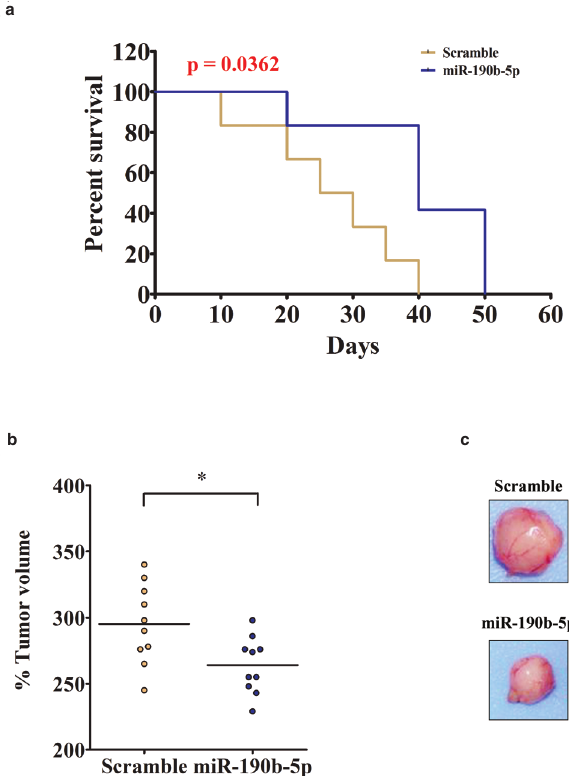
Fig. 6. MiR-190b-5p inhibits pancreatic cancer in mouse model. (a) Survival study of KPC mice administrated with 1 mg/kg of miR-190b-5p or scramble control formulated in nanoparticle-based vectors. KPC mice were enrolled onto studies when the tumor size was reaching 200 ± 50 mm 3 as measured by 3D ultrasonography. They were randomly assigned to receive miR-190b-5p or scramble, with 10 sub- jects in each group. The tumor size and mortality endpoint were accessed every 3 days throughout the study. (b) The tumor sizes of KPC mice in day 10 were compared between miR-190b-5p or scramble group as determined by 3D ul- trasonography. (c) The representative images of tumor sam- ples harvested from each experimental group (* P < 0.05, ** P < 0.01, and *** P < 0.001 as compared with control).